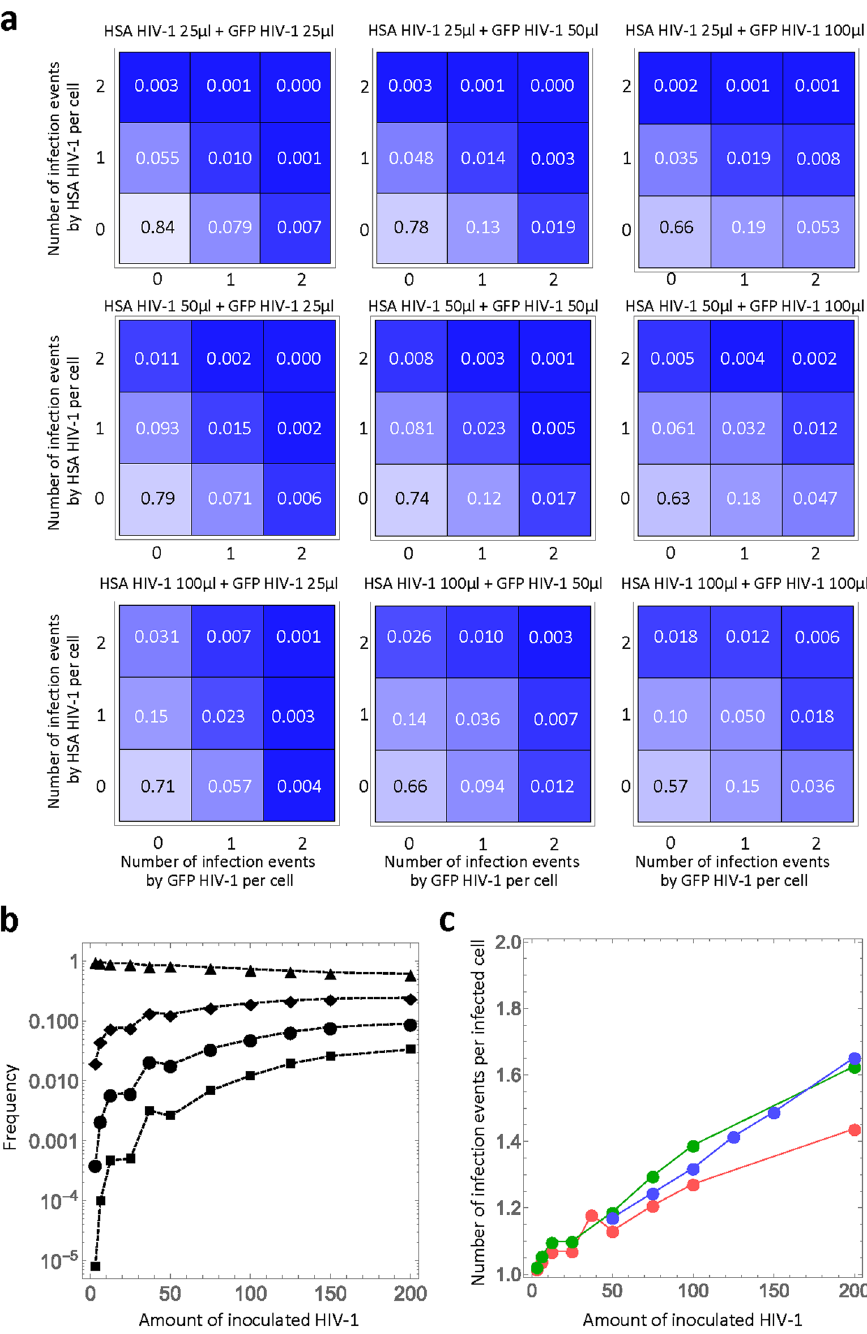
Figure 4. Quantitative analyses of multiple infection: ( a ) The distribution of the number of infection events per cell in double HIV-1 infection experiments with nine different combinations of virus amounts are shown. The number in each square is the estimated frequency of the corresponding infection events. (b) The mean frequency of the multiple infection events per cell inoculated with each different amount of HIV-1 is calculated. For double infection experiments, the amount is defined as the total inoculation of HSA and GFP HIV-1. The marks ▲ , ◆, ● , and ■ show the mean frequencies of zero, one, two, and three infection events per cell, respectively. (c) The estimated mean number of infection events per infected cell with different amounts of HIV-1 is calculated. The red, green, and blue curves correspond to the experiments with HSA and GFP HIV-1 single infections, and double infections, respectively. In ( a ), ( b ), and ( c ), these calculations were all performed using the mean value obtained from MCMC parameter inferences (Table